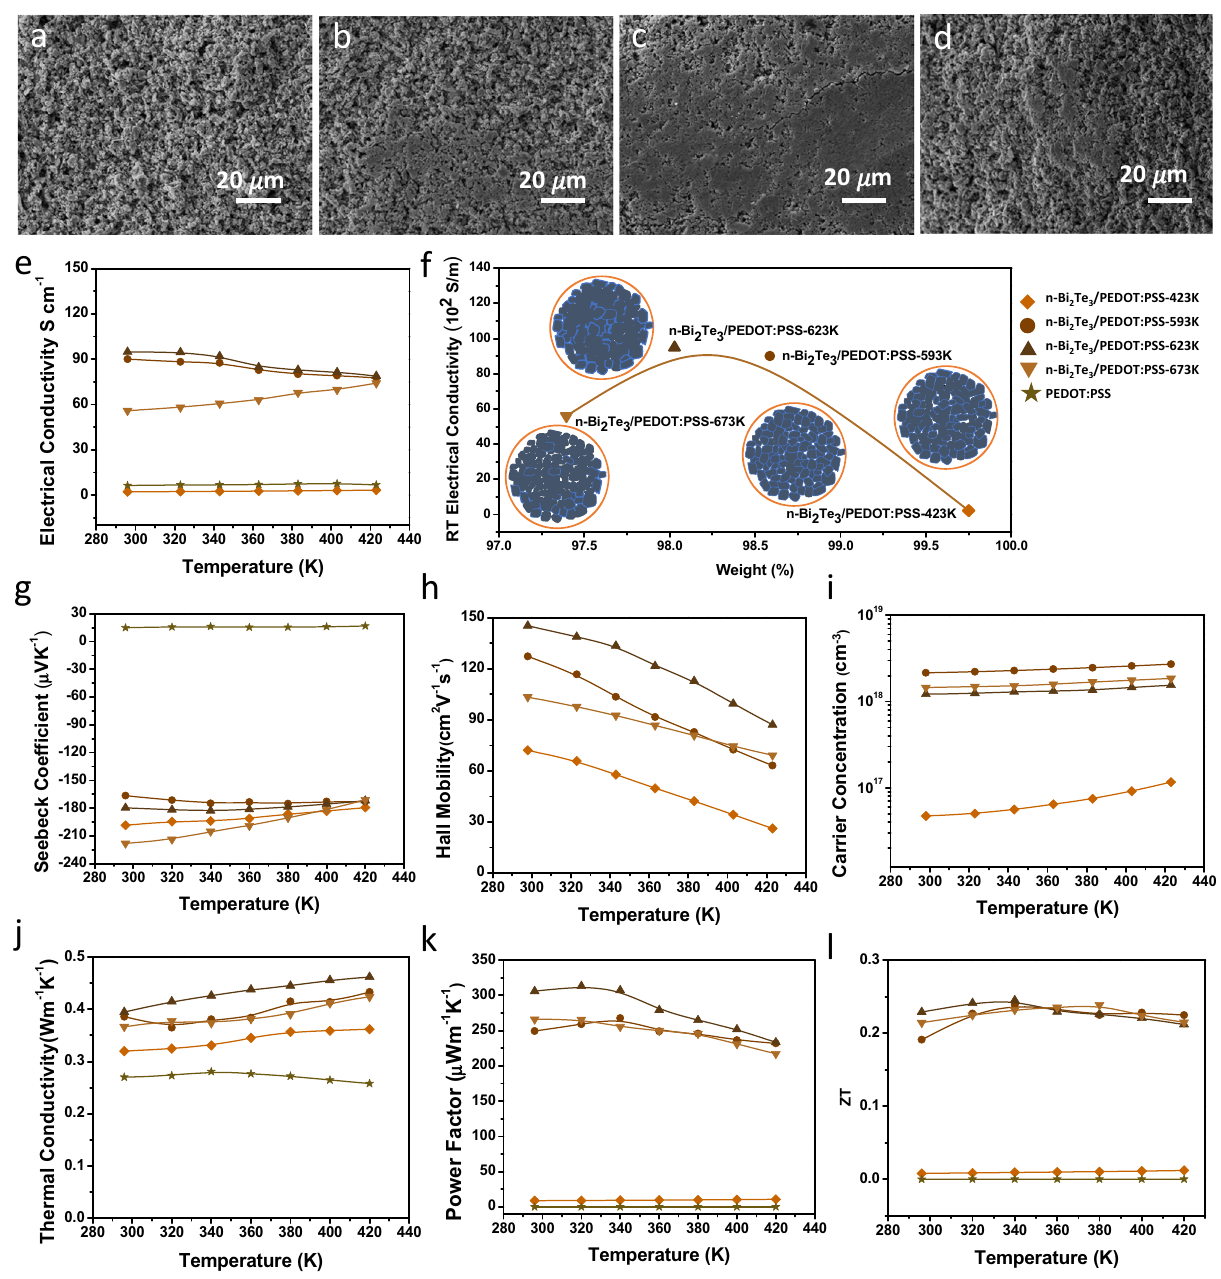
Fig. 3 Measurement results of n-Bi 2 Te 3 /PEDOT:PSS composites and pure PEDOT:PSS samples. a – d Top-view SEM images of n-Bi 2 Te 3 /PEDOT:PSS composites annealed at 423, 593, 623, and 673 K, respectively. e Curves of electrical conductivity vs. temperature of n-Bi 2 Te 3 /PEDOT:PSS, and PEDOT:PSS, respectively. f Room-temperature electrical conductivity of annealed n-Bi 2 Te 3 /PEDOT:PSS composites as a function of weight. g Seebeck coef fi cients of n-Bi 2 Te 3 /PEDOT:PSS samples and PEDOT:PSS. h Hall mobility, and i carrier concentration of n-Bi 2 Te 3 /PEDOT:PSS samples, j thermal conductivity, k Power factor, l fi gure of merit of n-Bi 2 Te 3 /PEDOT:PSS composites and